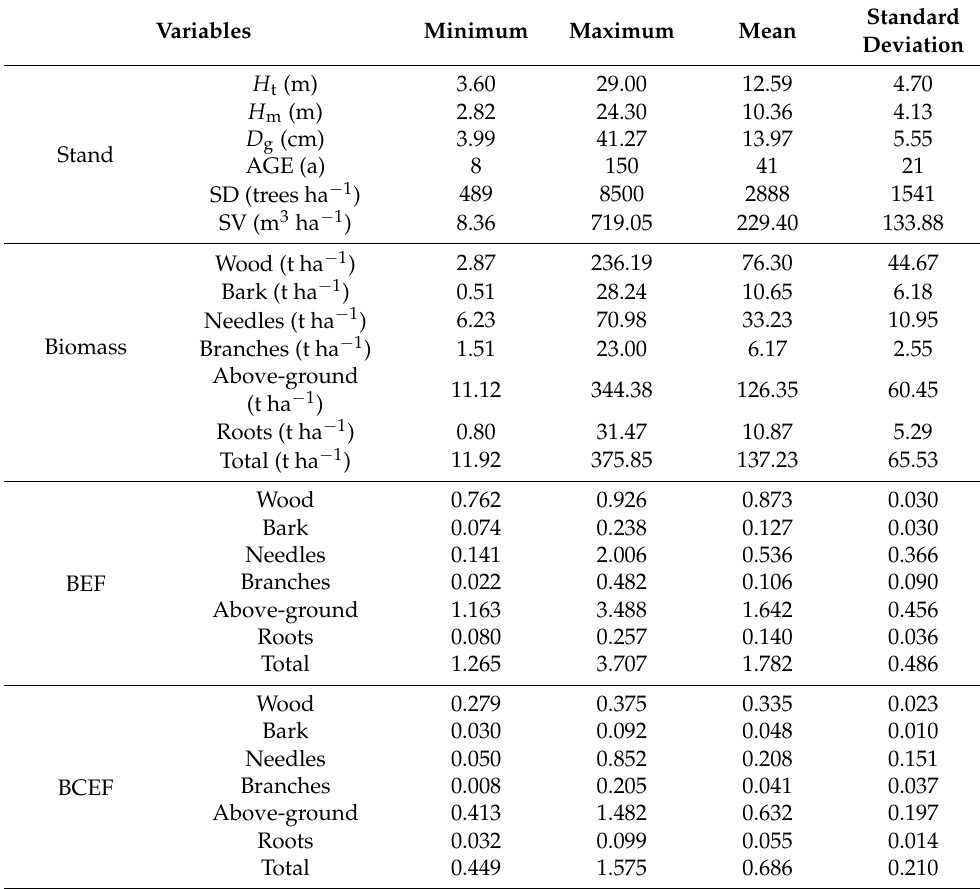
Standard Deviation